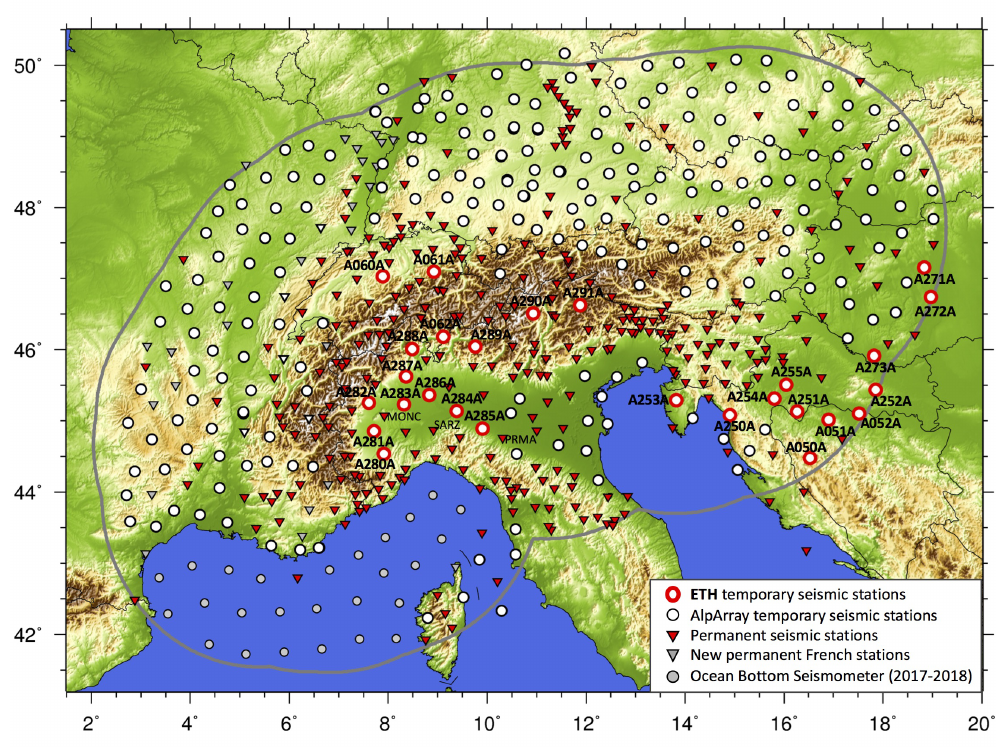
Figure 1. Map of the AlpArray broadband seismic stations, with the permanent stations (red inverted triangles), the new permanent French stations (grey inverted triangles) for which the installation is expected during the AlpArray project, the AlpArray temporary stations (white circles) and the Ocean Bottom Seismometer plan (grey circles). The Swiss installations are marked with red circles, labelled with the station name. The grey line marks the AlpArray boundary. MONC, SARZ and PRMA are three permanent INGV stations discussed in Fig.